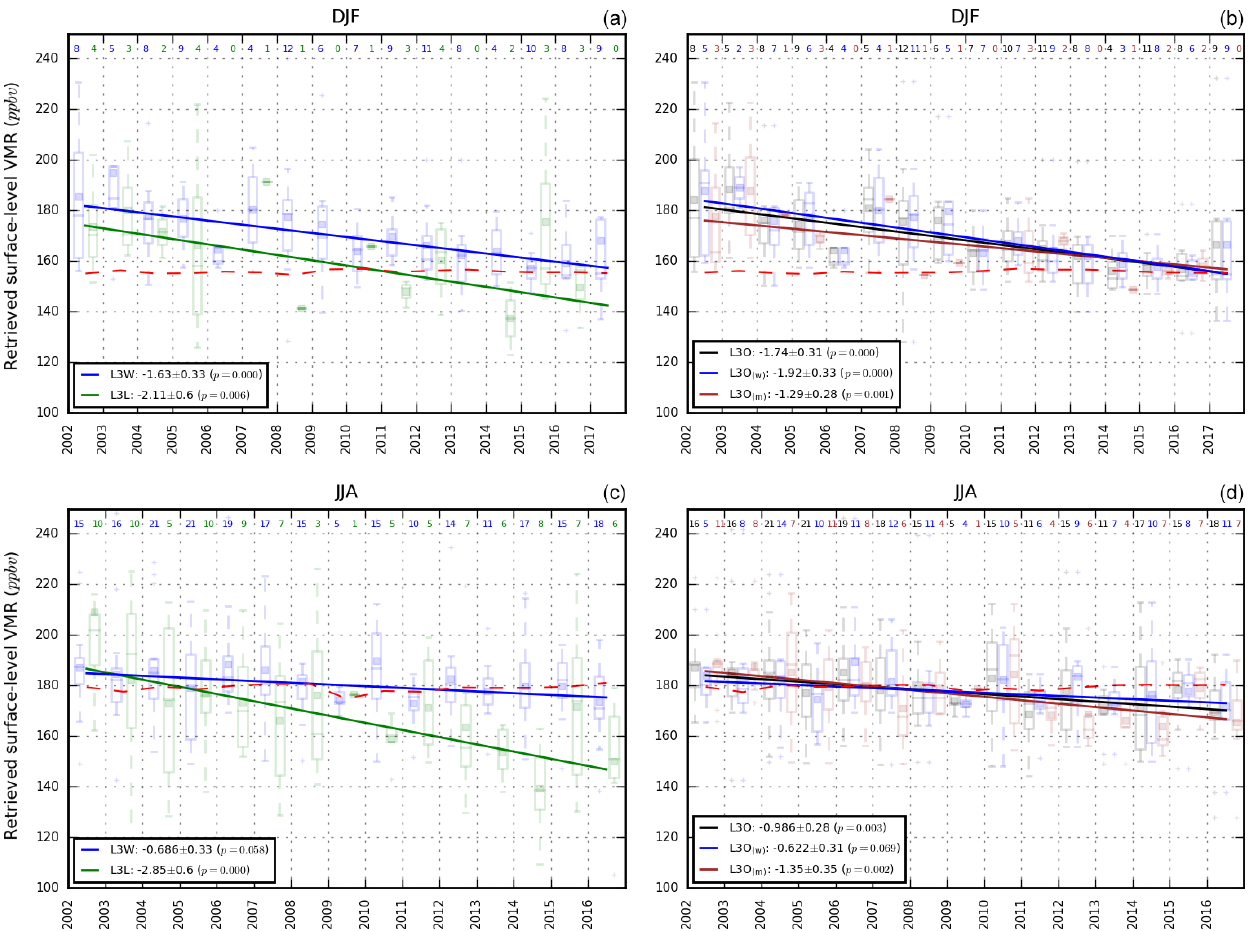
Figure 9. WLS regression best-fit lines calculated from seasonal mean retrieved surface VMR time series in DJF (a, b) and JJA (c, d) . (a, c) L3L (green) and L3W (blue); (b, d) L3O (black), L3O ( mixed ) (brown) and L3O ( water ) (blue). The daily observations corresponding to each seasonal mean value are represented by colour-coded boxplots each year, and the seasonal mean value is represented by filled squares. The dashed red line is the mean of the corresponding seasonal mean a priori data from each of the time series in the respective panel. Colour- coded values below the top x axis correspond to the number of observations each season. Values in the legend are the value, standard error and probability of zero value of the trend,